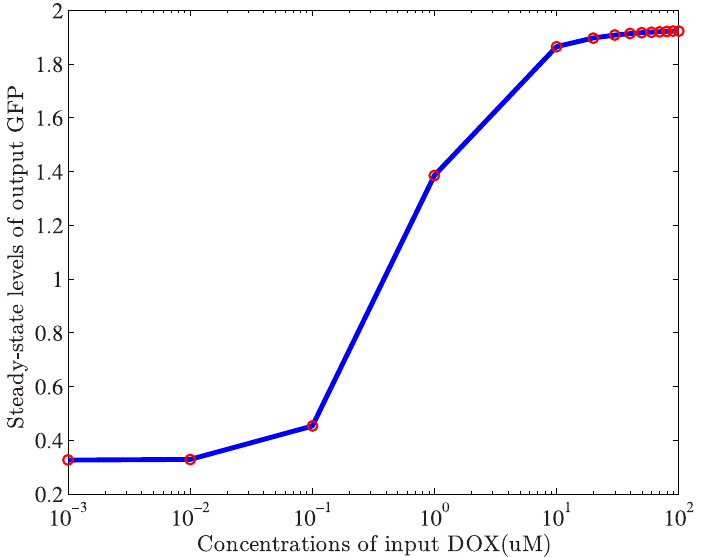
Fig 5. The input-output relations between input DOX and output GFP for buffered genetic circuit. Optimal experiment design requires a suitable input level to stimulate the system behaviors. In the numerical simulation, the variation range of input DOX concentration is selected as [10 − 3 ,10 2 ] μ M. The output-input ratio for buffered gene circuit decreases as the concentrations of input DOX increases, and remains stable a level of 0.0195.